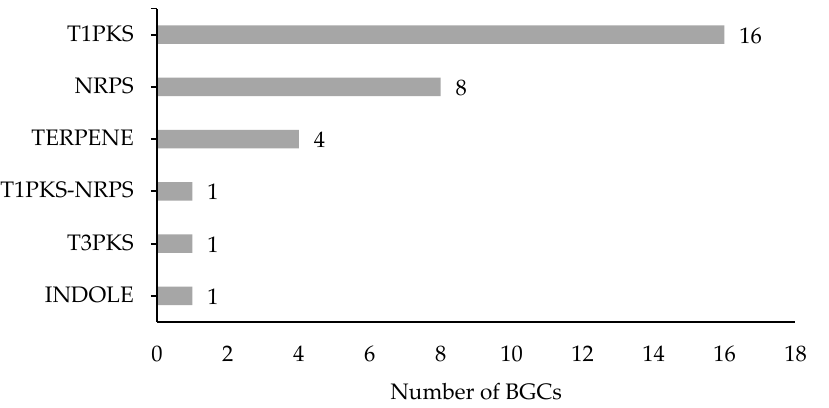
Figure 2. Classification of Biosynthetic Gene Clusters in M. fructicola based on the type of secondary metabolite they synthesize: polyketides (PKS), non-ribosomal peptides (NRPS), terpenes (TS) and alkaloids (INDOLE).